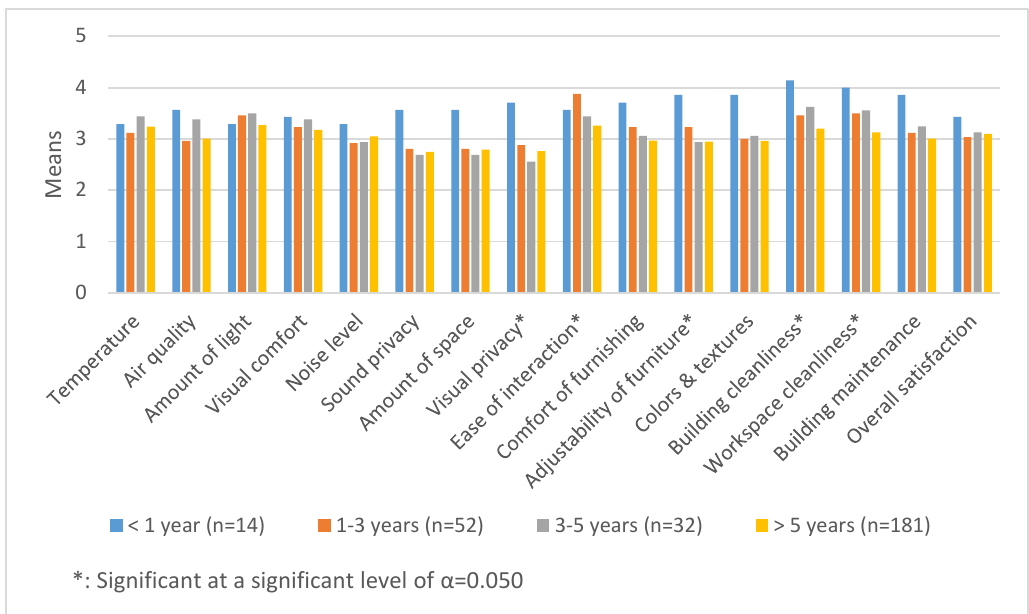
Figure 5. The impact of duration in the building on satisfaction with IEQ